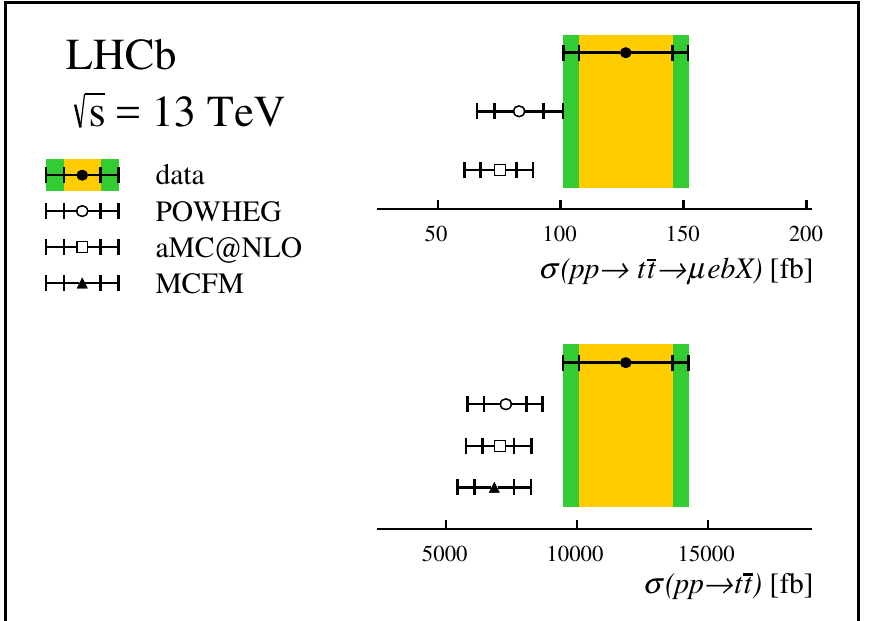
Figure 5 . Graphical comparison of the measured cross-sections with the predictions from the a MC@NLO , POWHEG and MCFM generators. For the data, the inner error band represents the statistical uncertainty, and the outer the total, while for the theoretical predictions, the inner band represents the scale uncertainty and the outer represents the total. The prediction is shown (above) for the muon, electron and jet (cid:12)ducial, and (below) for the top quark (cid:12)ducial region.